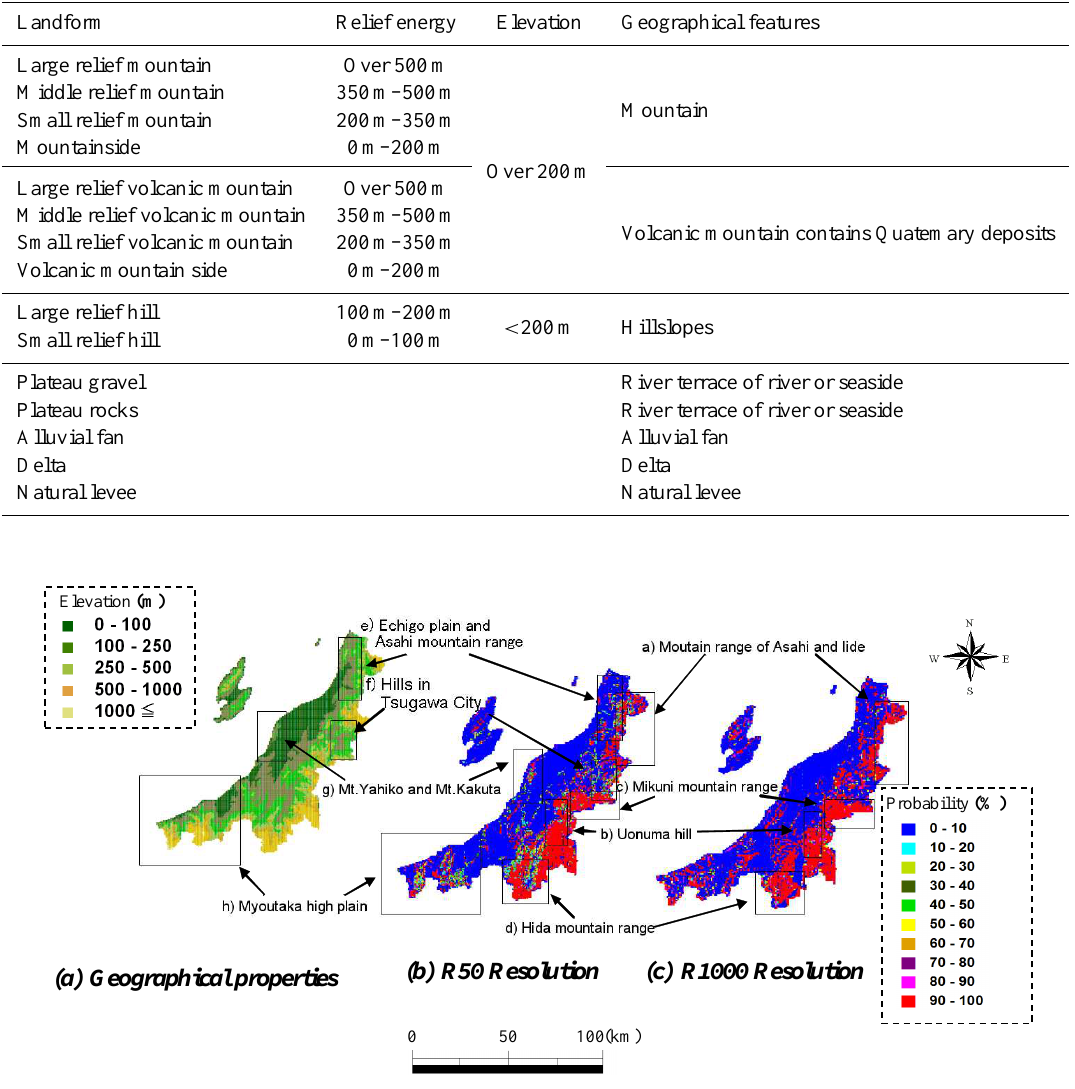
Fig. 11. Comparison of 50m × 50m (R50) resolution map and 1km × 1km (R1000) resolution map developed for Niigata prefecture (for extreme precipitation in 100 years).